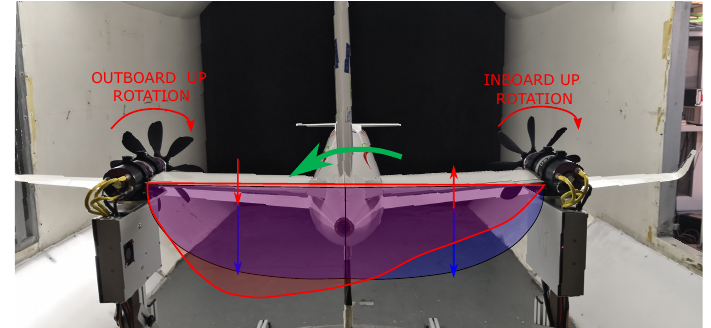
Figure 22. Qualitative explanation of induced rolling moment due to propulsive effects (Co-Rotating propellers). Due to the propellers rotation, the tail lift distribution and the resultant lift force are modified. The blue curve and arrows are representative of the lift distribution and resultant force in in prop-off condition, whereas the red curve and arrows are representative of the prop-on condition. The green arrow indicates the direction of the resulting rolling moment in prop-on